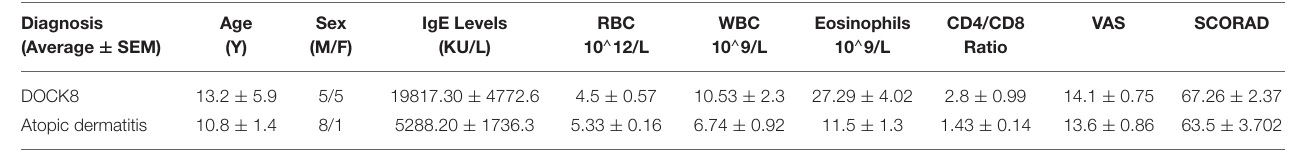
TABLE 1 | A summary of clinical demographics and laboratory readings of patients; the values are represented as the average and standard error of the mean (average ± SEM). Diagnosis (Average ±